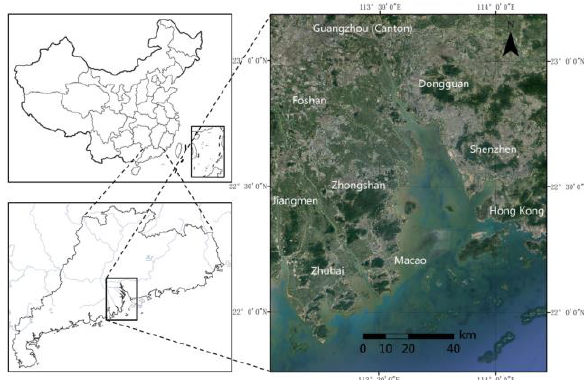
Figure 1. The location of the study area